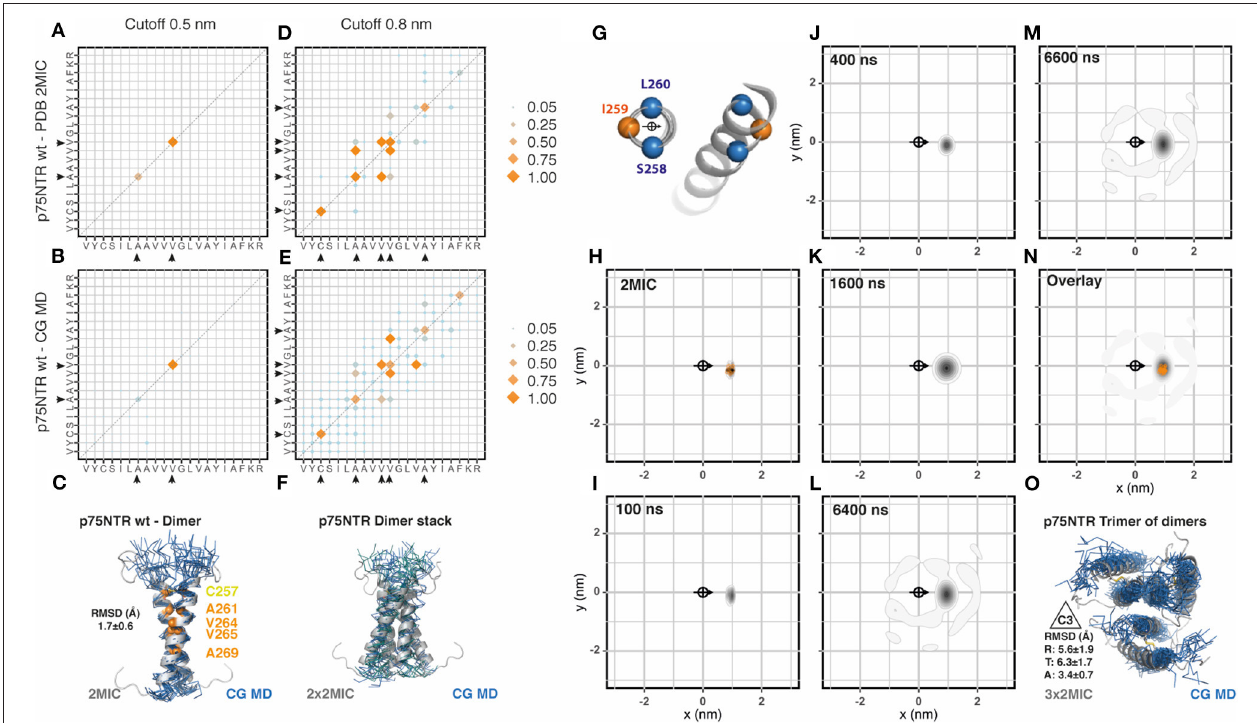
FIGURE 1 | p75NTR assembly. (A) Contact matrix of p75NTR wt NMR (PDB:2mic) at 0.5nm cut-off distance. The amino acid sequence corresponds to residues V254 to R274. Black arrowheads indicate the residues involved in these interactions. Data corresponds to the averaged 10 NMR models. Scales correspond to the number of contacts normalized to the most frequent one [NC ij /major(NC ij )]. (B) Same as (A) , for p75NTR coarse grained molecular dynamic (CG-MD) simulation. The analysis was performed on the full system (36x36) between 3 and 6 µ s. (C) Alignment of the p75NTR NMR average model with a random p75NTR CG-MD dimer, together with the analysis of the averaged root mean square deviation (RMSD) of the alignment. (D) Same as (A) , but using a cut-off distance of 0.8nm. (E) Same as (B) , but using a cut-off distance of 0.8nm. (F) Example of stable interactions between dimers observed along the simulation, aligned to the reference structure 2 mic. (G) Residues chosen for the centroid and orientation vector used for radial distribution analysis. (H) Radial distribution analysis of p75NTR NMR structure 2mic, analyzed as coarse grained structure. The scale corresponds to the 2D-density function built from the scatter plot of XY -coordinates, as described in Methods. (I–M) Radial distribution analysis of different snapshots of p75NTR CG-MD at the indicated time points. (N) Overlay of the radial distribution of the reference structure (2mic, orange dots) and the CG-MD structures (gray density scale). (O) Example of a stable trimer of dimers found at early time points, assembled into the characteristic 3-fold symmetry axes C3, together with the averaged radial (R), tangential (T), and axial (A)